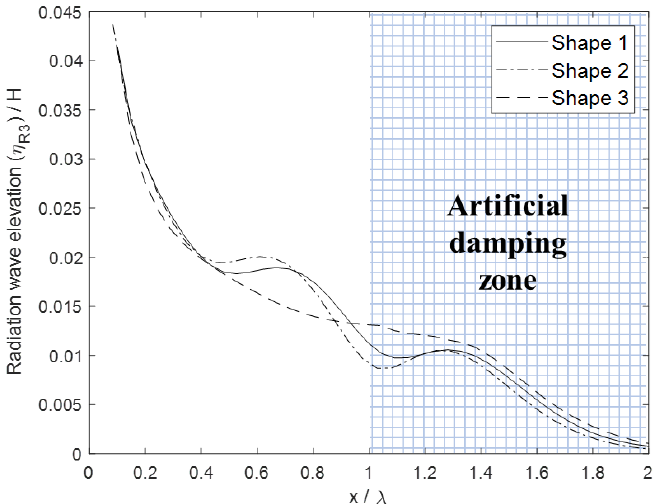
Figure 8. Longitudinal (x direction) distribution of the radiated wave amplitudes for three different shapes of ramp functions with the 𝜙 𝑛 − 𝜂 -type damping method ( 𝜔 = 1.5 rad/s , 𝜇 0 = 2.0 , 𝐿 𝑑𝑎𝑚𝑝 /𝜆 = 1.0 ).